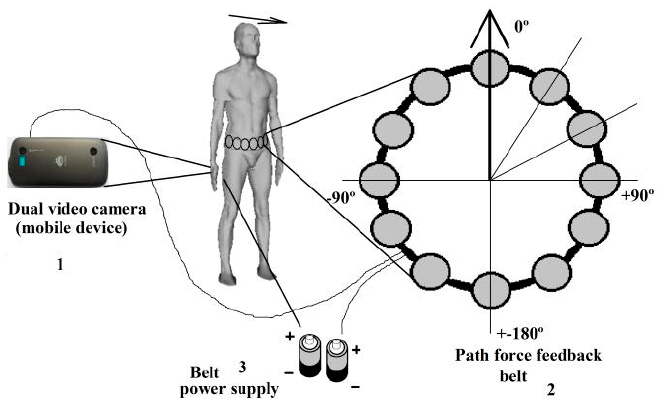
Figure 23. The prototype of Path Force Feedback belt design [46].